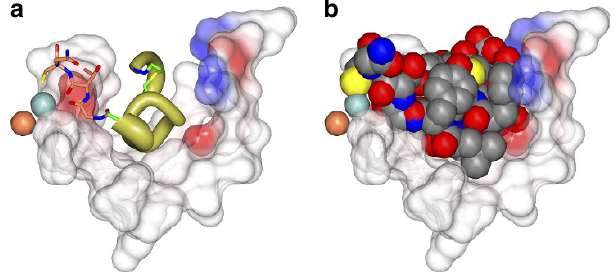
Figure 6 | Modelling of C-terminal residues of Ce-2 onto Ce-2d. ( a ) The Ce-2d macrocycle is shown as worm a -chain (gold) representation scaled by B-factor within a cavity of C. elegans iPGM residues (transparent spheres) formed from residues within 5Å of cyclic peptide. The C-terminal residues, -Gly12-Thr13-Cys14-Gly15 of Ce-2 were modelled onto the iPGM (cid:3) Ce-2d complex and are shown as tan sticks extending from Ce-2d . Electrostatic surface of the binding cavity is also shown. ( b ) Ce-2 van der Waals radii shown using a CPK model. The Cys14 sulfhydryl is shown in